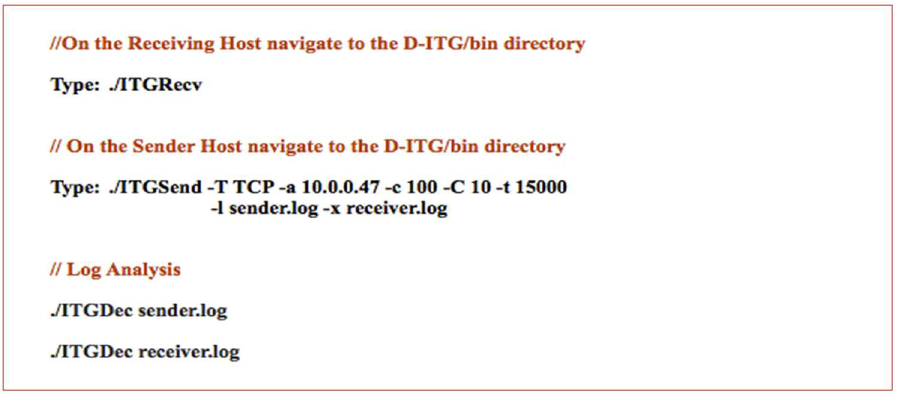
Fig 6. D-ITG single flow